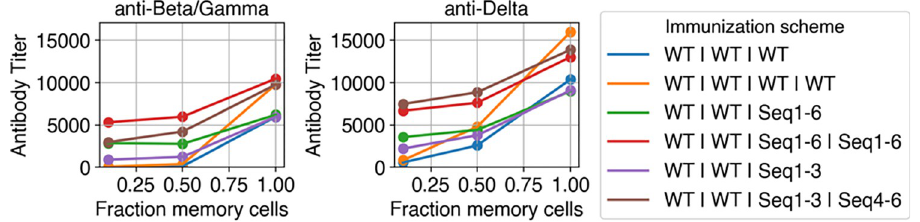
Fig 6. Titers against current variants are affected by the fraction of GC-seeding cells that are memory cells. Titers against Beta/Gamma and Delta variants as a function of the fraction of GC-seeding cells that are memory cells. Beta and Gamma variants carry biochemically similar RBD mutations, so they are equivalent in this